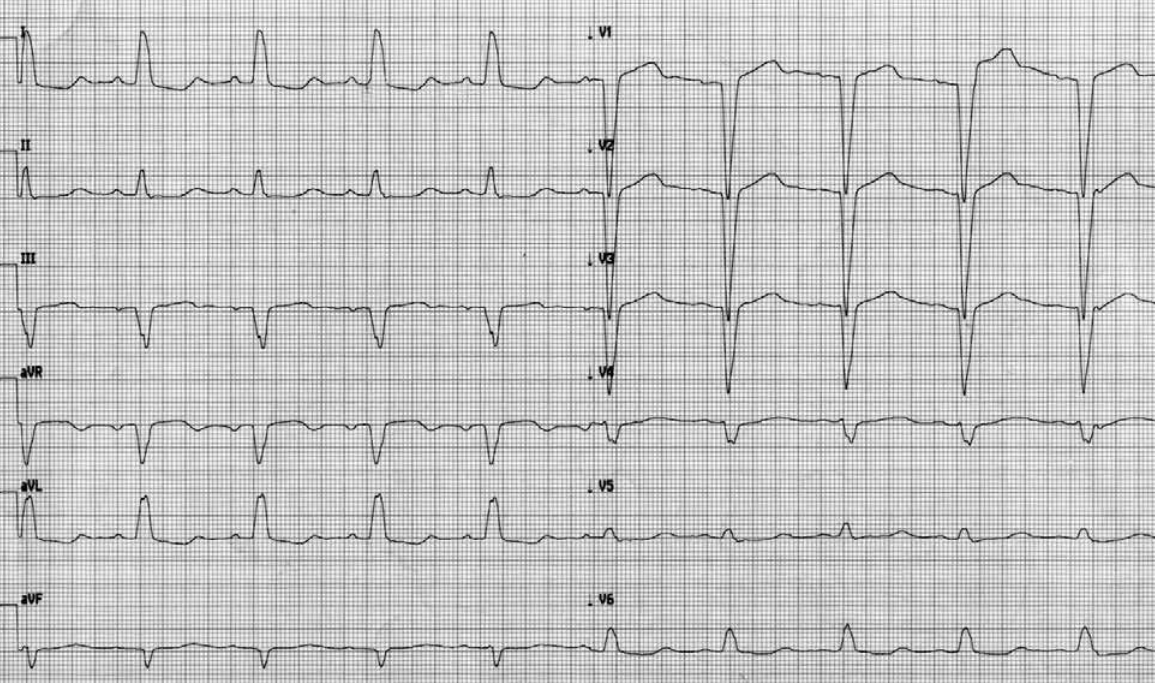
Figure 2: ECG on admission. LBBB with broadening of the QRS complex to 160 ms. Elongated corrected QT interval (Bazett‘s formula) to 0,61